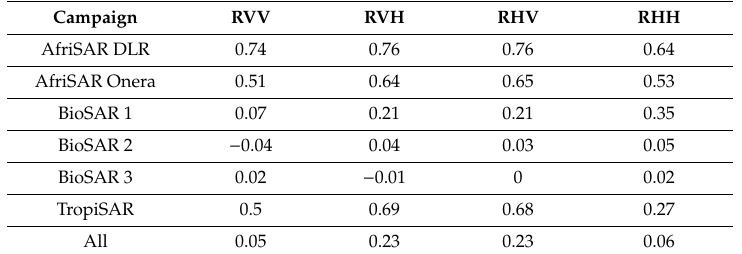
Table 1. Correlation coe ffi cients (R) between σ ◦ at various polarizations and in situ